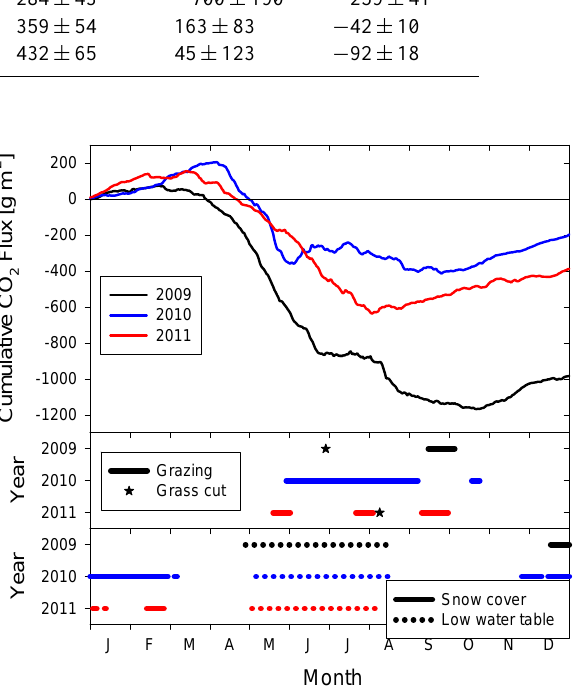
Fig. 3. Cumulative CO 2 fluxes (upper panel) shown together with management activities (middle panel), snow cover duration and wa- ter table height (lower panel). See text for the definition of “low” and “high” water